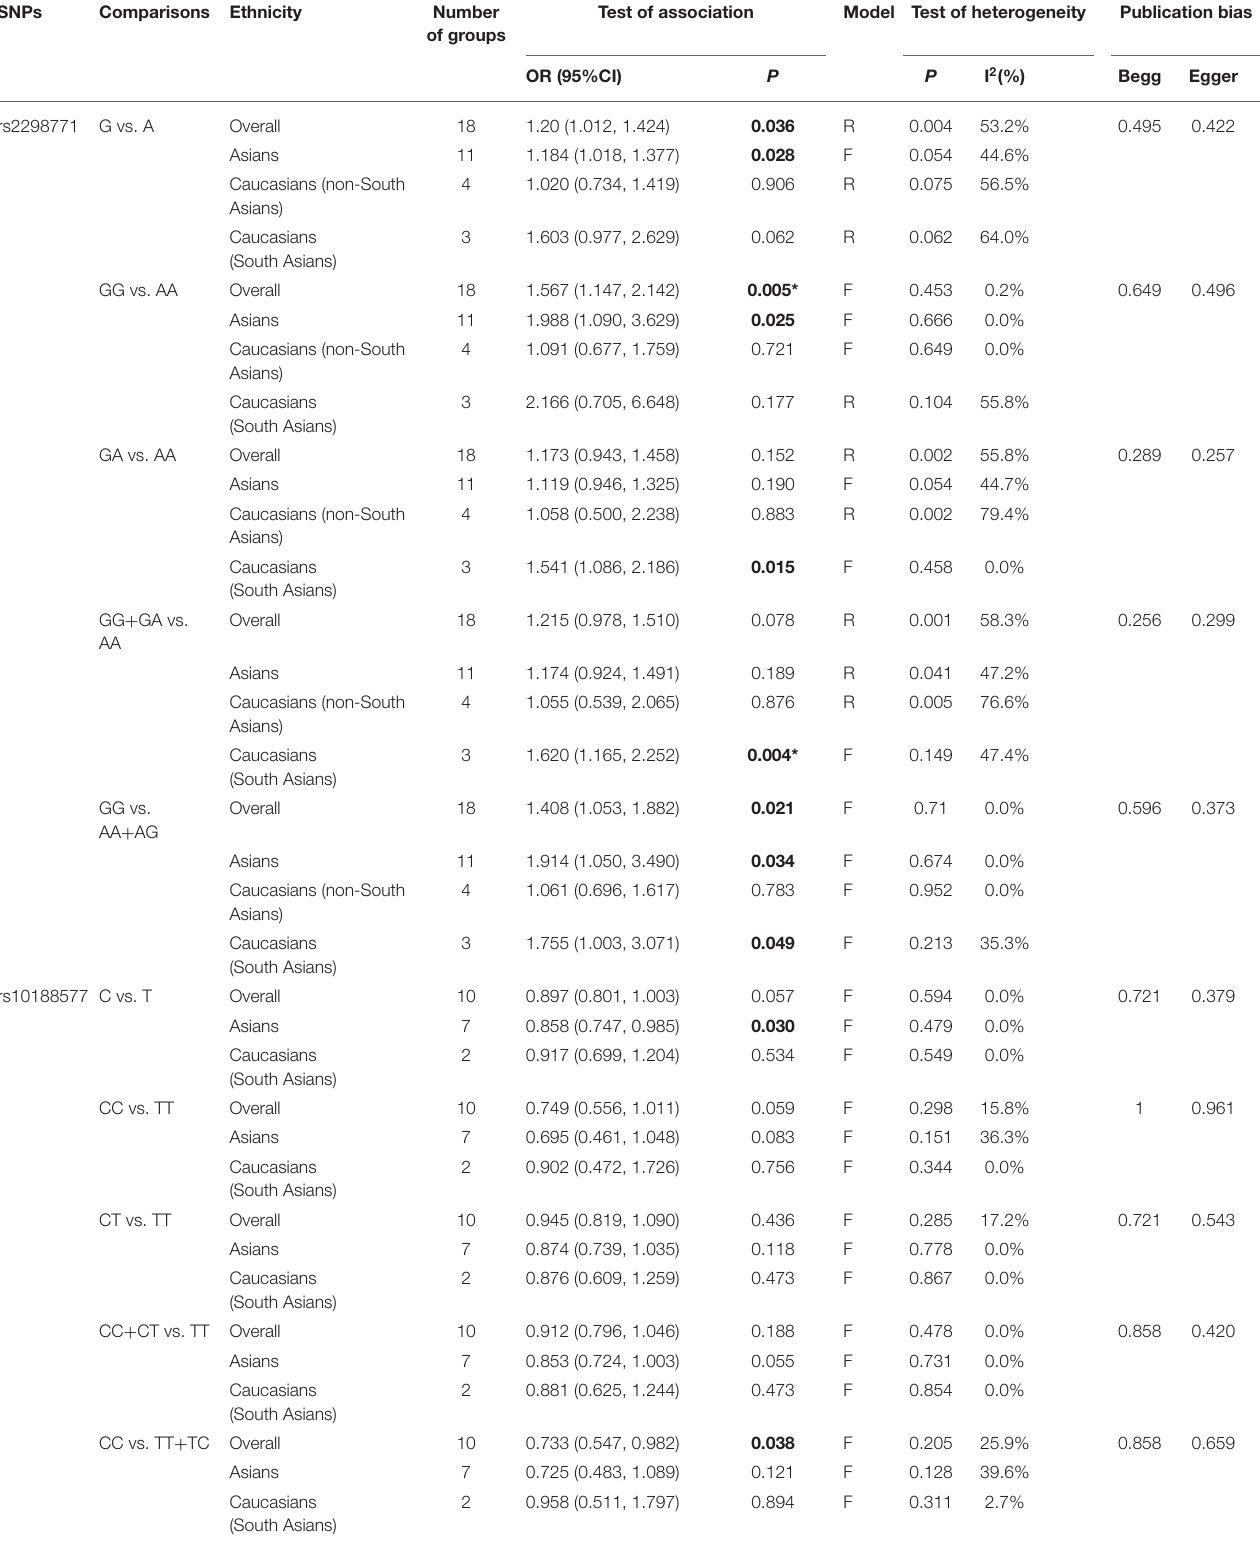
TABLE 3 | Summary of the association between SCN1A and SCN2A polymorphisms and resistance to AEDs.